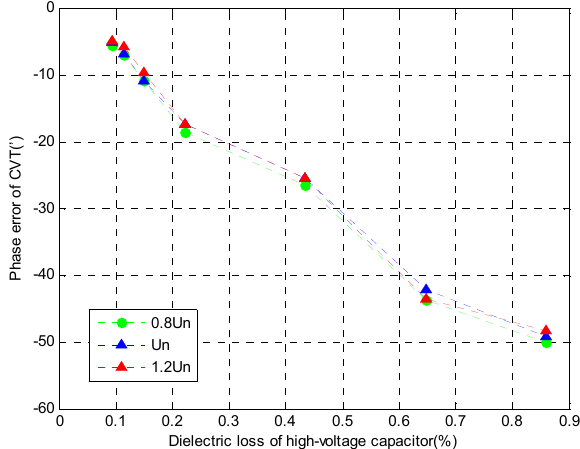
Figure 18. CVT phase error with different high-voltage capacitor dielectric loss factor.